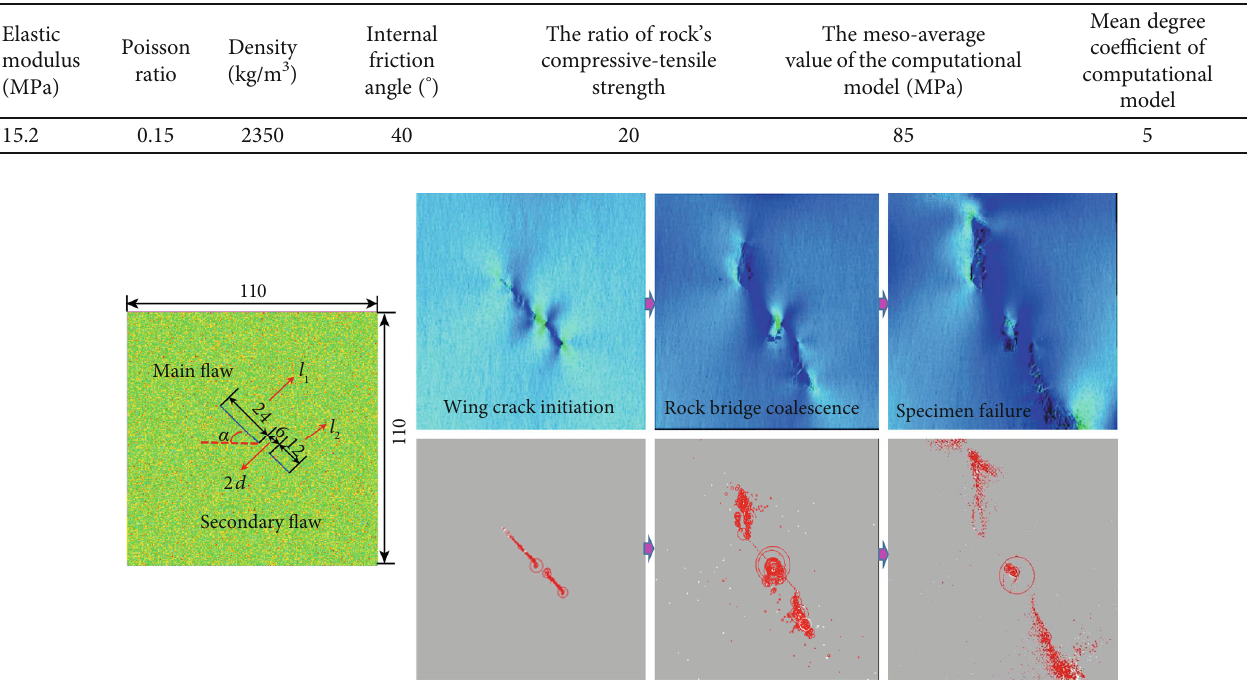
= 24mm , 2 l = 12mm , 2 d = 6mm . 1 2